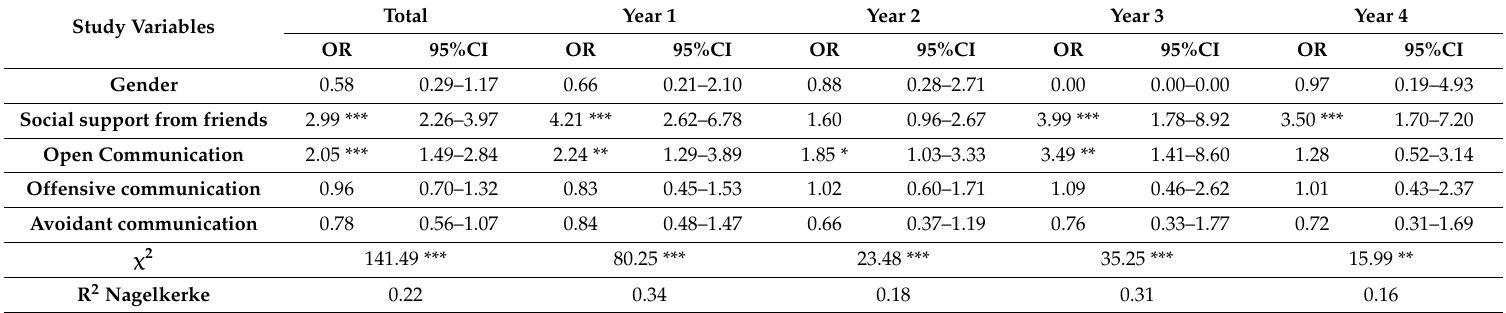
Table 3. Logistic regression analyses examining the associations linking subjective well-being, social support from friends, and family communication per academic year, with gender as a control